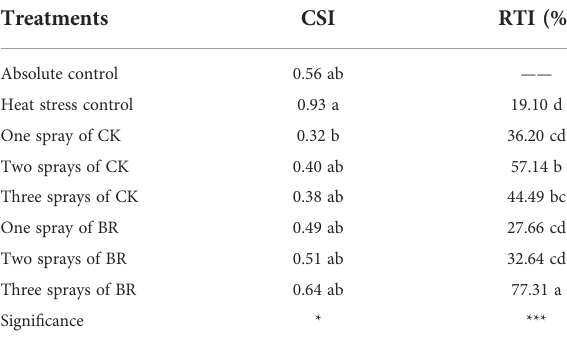
TABLE 4 Effect of the number of applications of two growth regulators (cytokinins (CK) or brassinosteroids (BR)) on the crop stress index (CSI) and relative tolerance index (RTI) of rice plants of genotype Federarroz 2000 subjected to combined heat stress (40°C day/30°C night) at 88 days after emergence (DAE).